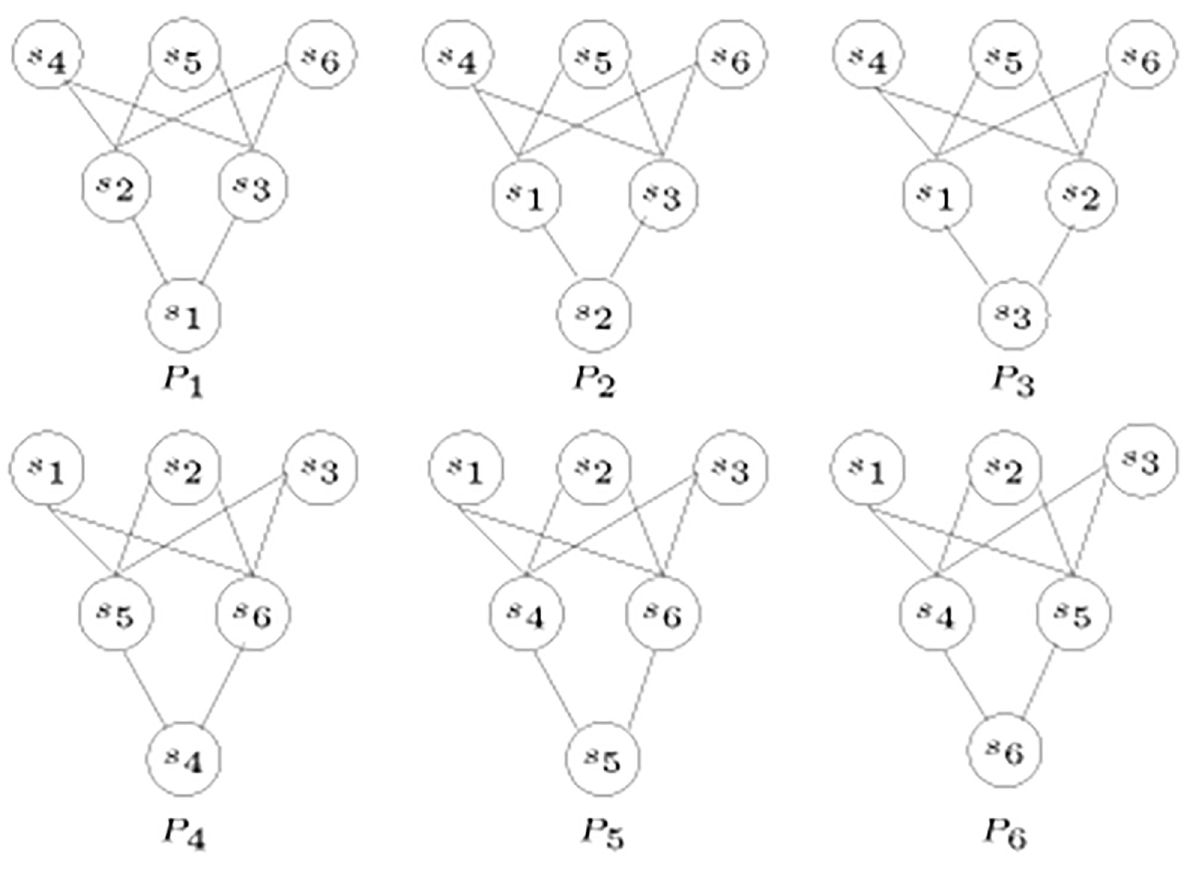
Fig 13. Diagrams for posets.